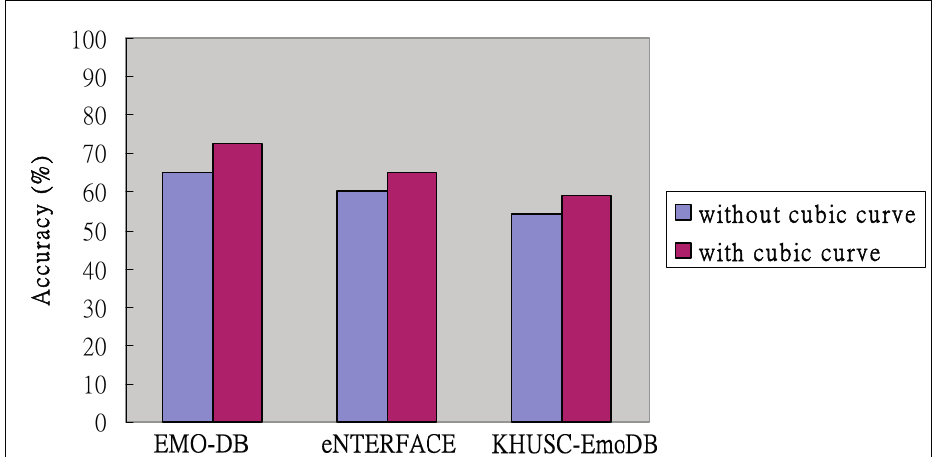
Figure 7. Recognition accuracy without/with cubic curve among the three